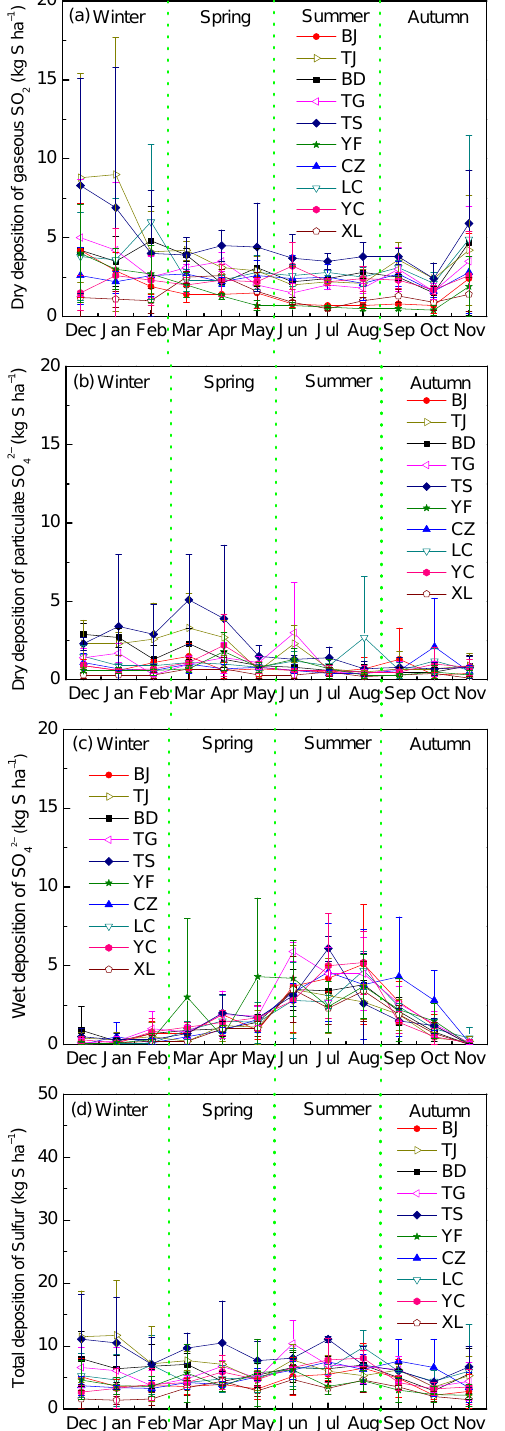
Fig. 3. Seasonal variations of the atmospheric deposition flux of sulfur at the ten selected sites in Northern China. The data shown are the monthly mean ± standard deviations of 3-yr observations (from December 2007 to November 2010). The definition of the site codes is found in Sect.